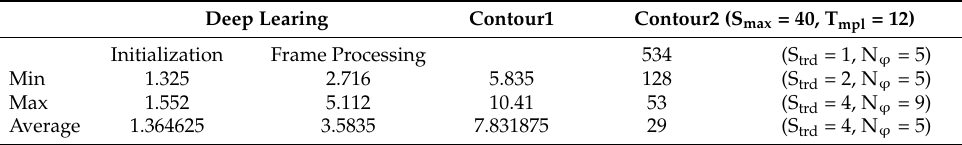
Table 7. Latency of the fish morphological feature measurement approaches (in seconds). Deep Learing Contour1 Contour2 (S max = 40, T mpl =